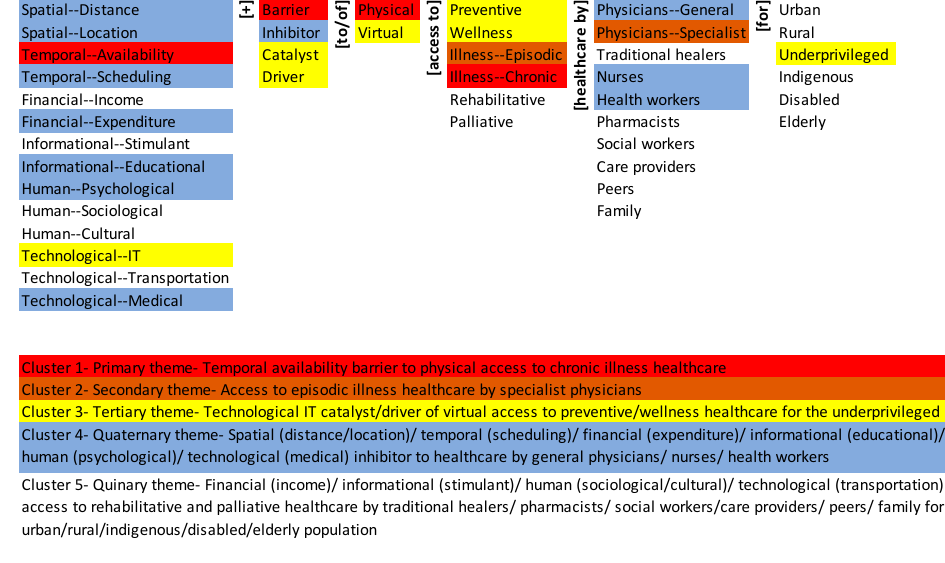
Figure 4. Theme map of the research on access to healthcare during COVID-19.